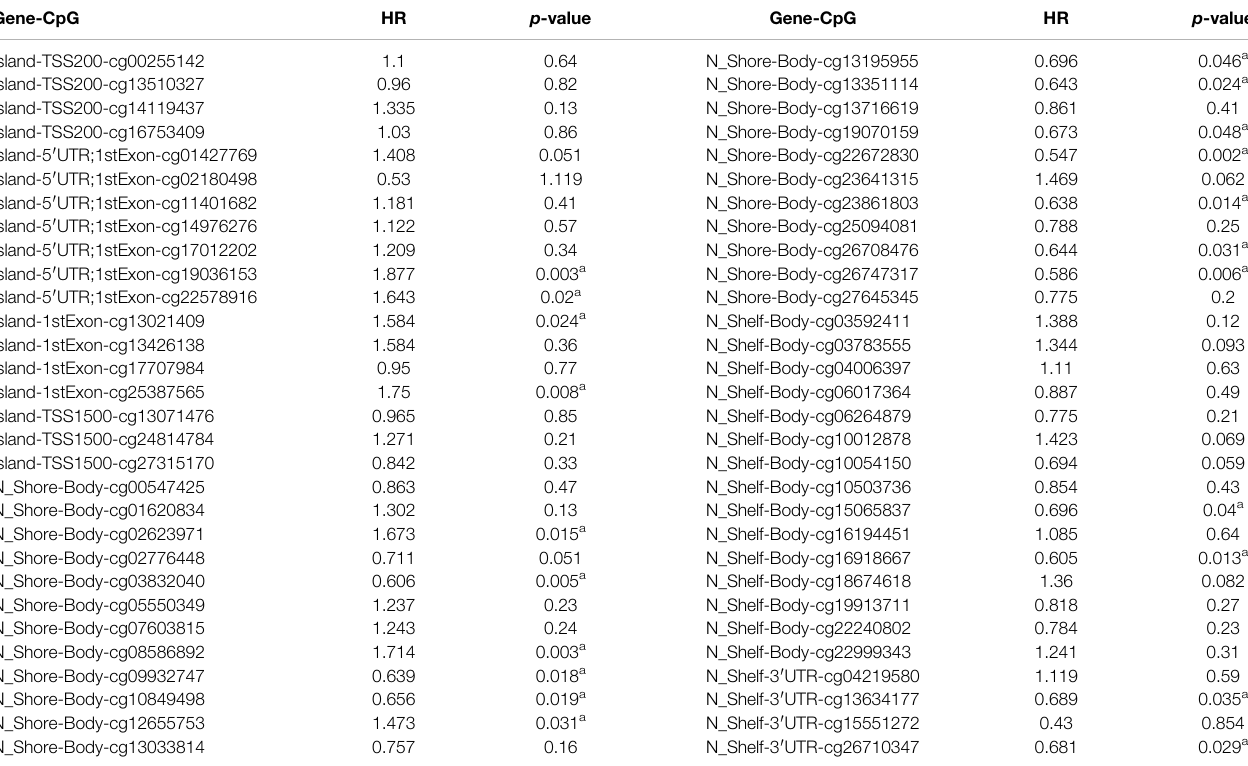
TABLE 1 | The prognostic values of CpGs in NEU1 (MethSurv database).